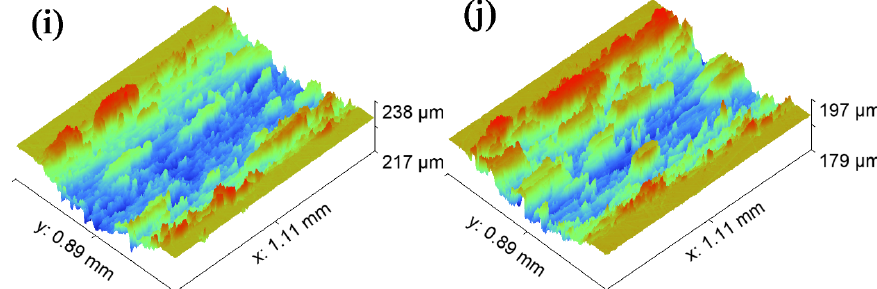
Figure 8. Morphology of wear marks of different samples: ( a ) untextured rotation radius of 15 mm; ( b ) untextured rotation radius of 22.5 mm; ( c ) 0.4 mm groove width mechanical texture rotation radius of 15 mm; ( d ) 0.4 mm groove width mechanical texture rotation radius of 22.5 mm; ( e ) 0.6 mm groove width mechanical texture rotation radius of 15 mm; ( f ) 0.6 mm groove width mechanical texture rotation radius of 22.5 mm; ( g ) 0.8 mm groove width mechanical texture rotation radius of 15 mm; ( h ) 0.8 mm groove width mechanical texture rotation radius of 22.5 mm; ( i ) 1.0 mm groove width mechanical texture rotation radius of 15 mm; ( j ) 1.0 mm groove width mechanical texture rotation radius of 22.5 mm.